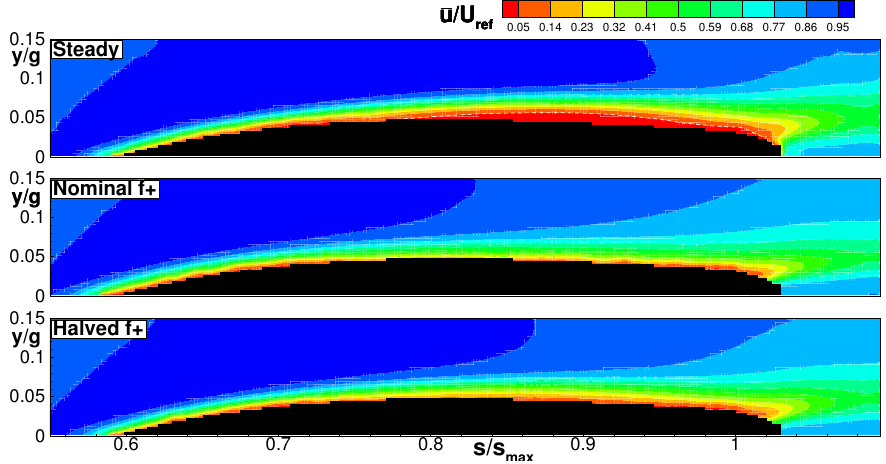
Figure 2. Time-mean streamwise velocity component. From top to bottom: steady inlet flow case, nominal reduced frequency, half-reduced frequency. The dividing streamline is traced by the dashed white line for the steady